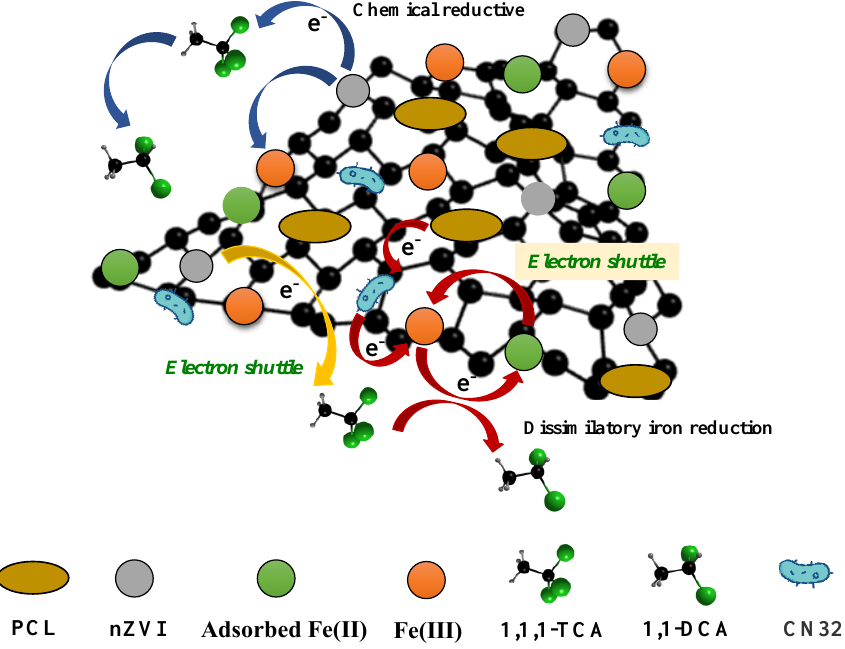
Figure 9. The mechanism scheme for 1,1,1-TCA removal enhanced by nZVI@PBC coupling with CN32.